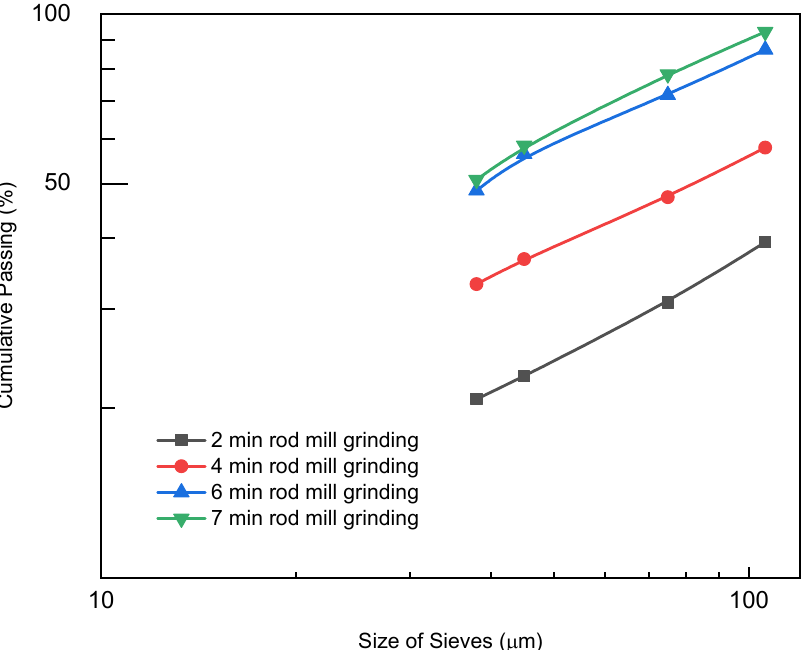
Figure 5. Variation of the cumulative particle size distribution of skarn phosphate sample as a function of grinding time in a Titan rod mill.